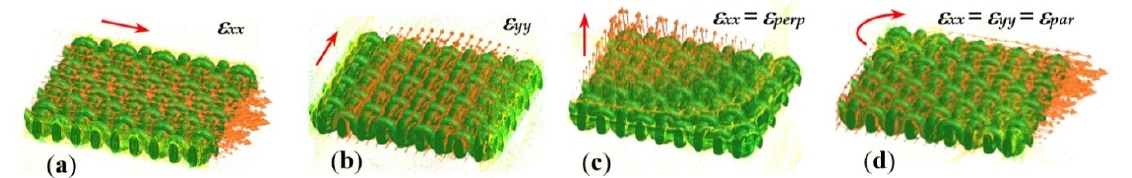
Figure 4. Artificial sample (3D-woven fabrics) in a rectangular resonator (not shown), which supports different modes with mutually perpendicular E fields (red arrows) along the axes: 0 x , 0 y , 0 z and in the plane 0 xy in the Ku-band (modes: TE 011 ( a ); TE 101 ( b ); TM 010 ( c ); TE 111 ( d ).